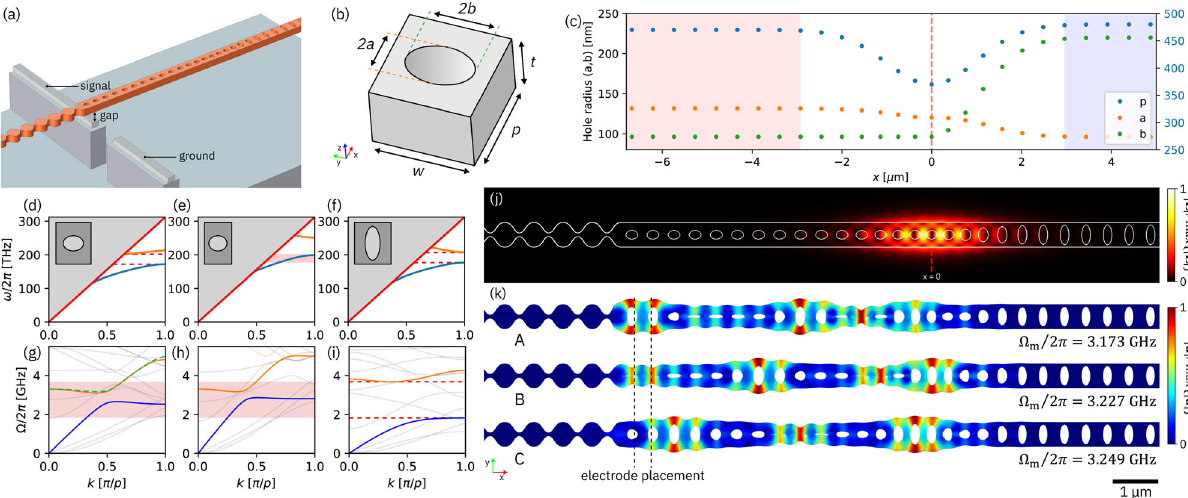
Fig. 1 GaP optomechanical crystal cavity design. a Illustration of the cavity suspended over an electrode pair. b Schematic of unit cell ( t = 300 nm, w = 550 nm). c Variation of unit-cell parameters as indicated in b along the cavity x -axis. The shading indicates the phononic waveguide (red), cavity (white), and input-mirror (blue) regions. d – f Photonic band structure of the unit cell for the phononic waveguide, cavity center, and input mirror, respectively. The light line is indicated in red. The red-shaded region in e is the intersection of the photonic bandgaps in d and f . g – i Phononic band structure of the unit cell ordered as in d – f . The mechanical breathing modes are indicated in blue and orange. The red shaded region in g and h corresponds to the phononic bandgap in i . For comparison, the upper breathing mode band for the unit cell at the cavity center is overlayed in g as a dashed green line scaled for the difference in period p . j FEM simulation of the localized optical mode. The color scale indicates the magnitude of the electric fi eld ∣ E ∣ . k FEM simulation of three extended mechanical breathing modes. The color scale indicates the magnitude of the mechanical displacement ∣ u ∣ .